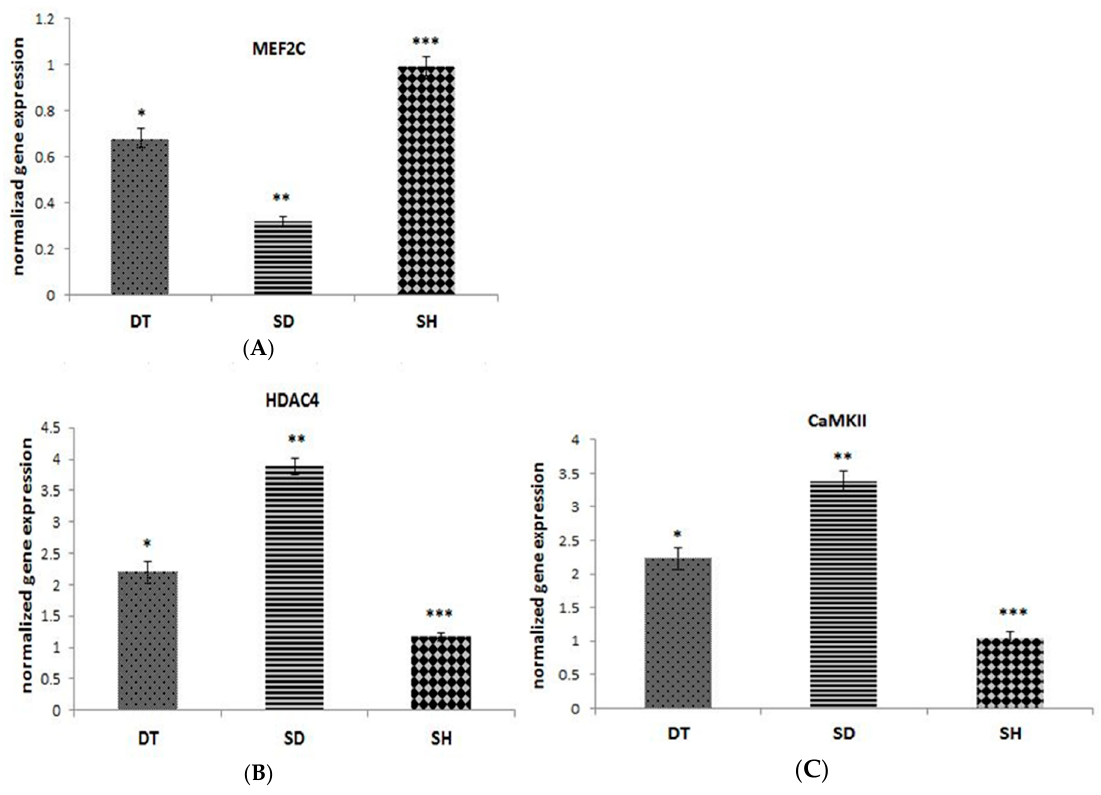
Figure 3. The normalized gene expression of MEF2C ( A ), HDAC4 ( B ), and CaMKII ( C ) at the end of six weeks ET in DT, SD, and SH groups. *; significant difference p < 0.001 between DT and SD groups, **; significant difference ( p < 0.001) between SD and SH groups, ***; significant difference ( p < 0.001) between DT and SH groups. Abbreviations; ET: Endurance training, DT: Diabetic training, SD: Sedentary diabetic, SH: Sedentary healthy. Data are expressed as mean ± SEM.